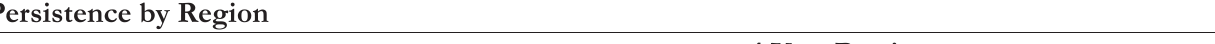
Table 2. Example of Table Shells (continued) Persistence by Region